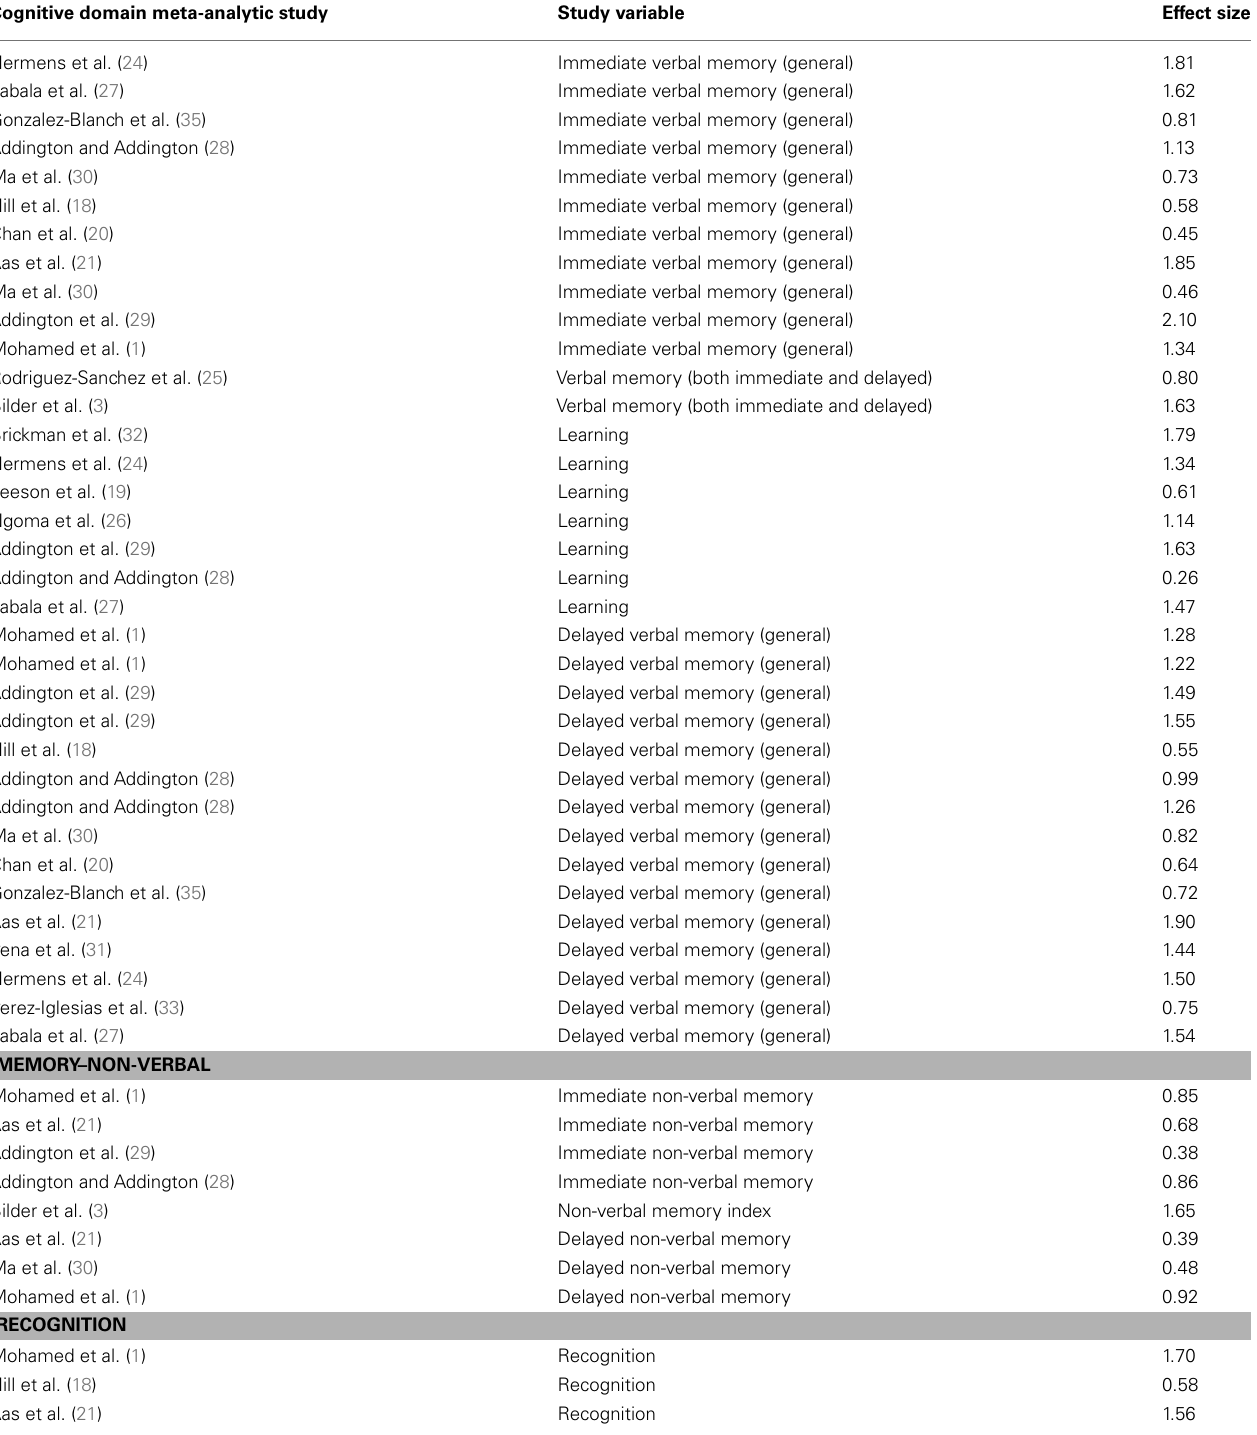
Table 3 | Studies comparing patients with first-episode psychosis and healthy controls on memory function